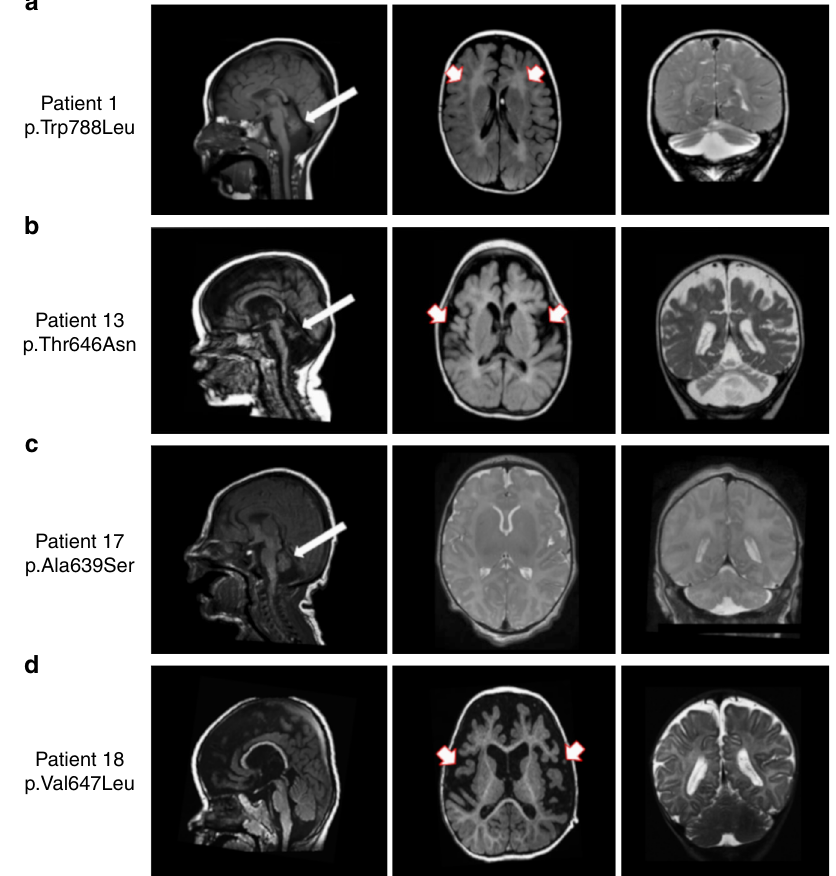
Fig. 2 Brain imaging in 4 individuals with GRIA2 -related DEE and brain and cerebellar atrophy. a Sagittal T1 weighted (left panel), Axial T1 weighted (middle panel), and c oronal T2 weighted (right panel) images from Patient 1 (carrying the de-novo p.W788L mutation) scanned at the age of 3 years. There is reduction in the cerebral white matter (red and white arrows), brain volume and marked cerebellar atrophy with vermian de fi ciency (white arrows). b Sagittal T1 weighted (left panel) images from Patient 13 (carrying the de-novo p.T646N mutation) at the age of 2 months, and axial T1 weighted (middle panel) and coronal T2 weighted images (right panel) from the same Patient at the age of 11 months demonstrate white matter signal abnormality (white and red arrows) with generalized reduction in the cerebral white matter volume and cerebellar atrophy with vermian de fi ciency (white arrows). c Sagittal T1 weighted (left panel), Axial T2 weighted (middle panel) and coronal T2 weighted (right panel) images from Patient 17 (carrying the de-novo p. A639S mutation) at the age of 6 days; there is an underdeveloped/hypoplastic cerebellum (white arrows) and delayed maturation of myelin. d Sagittal T1 weighted (left panel), axial T1 weighted (middle panel) and coronal T2 weighted (right poanel) images from Patient 18 (carrying the de-novo p.V647L mutation) scanned at the age of 18 months; there is a global cerebral atrophy and white matter changes which suggest hypomyelination (white and red arrows). Although the volume of the cerebellar hemispheres is preserved, atrophy of the inferior cerebellar vermis and wide cerebellar sulci are